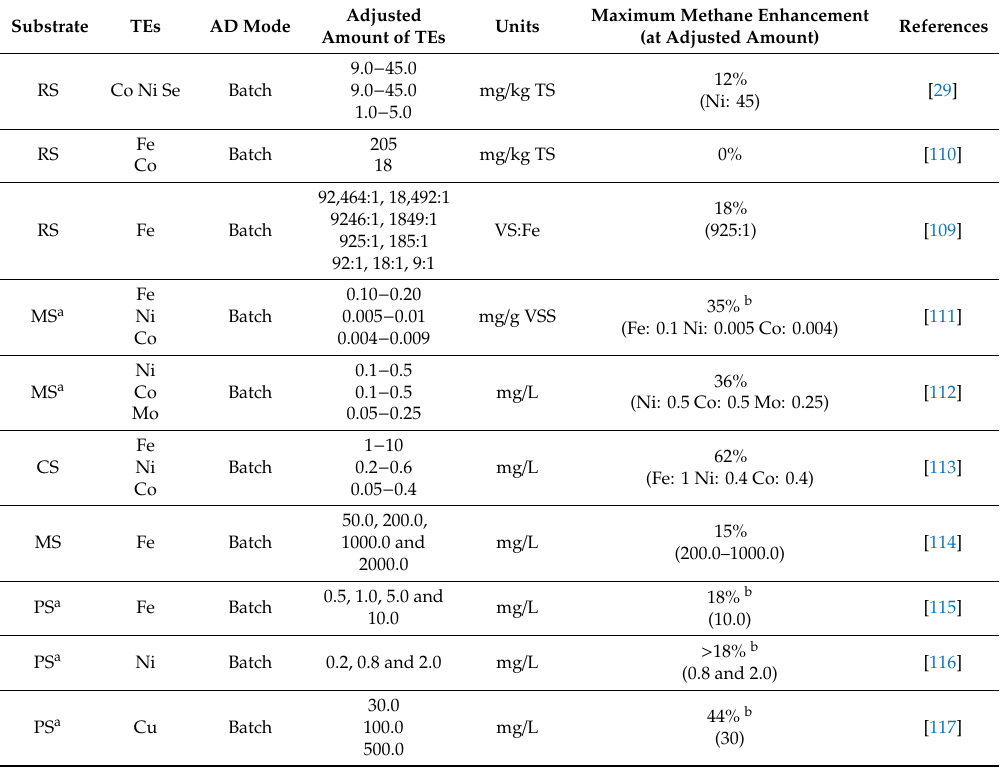
Table 9. E ff ect of addition of TEs on the methane yield in the AD of RS and other straws. Maximum Methane Enhancement Adjusted Units Substrate AD Mode Amount of TEs (at Adjusted